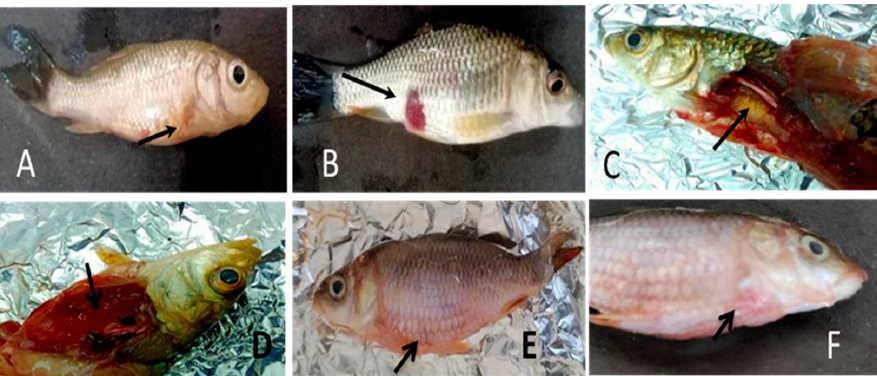
Figure 13. Symptoms post-challenge in fish prior to mortality ( A , E , F ) External hemorrhage, Reddened fins, Iridial hemorrhage, ( E ) Swollen abdomen, Detachment of Scales ( B ) Open bloody sores/ulcers, exophthalmia. ( D ) Internal hemorrhage/Ulcerative necrosis ( C ) Friable liver, and congested kidney with serous fluid.